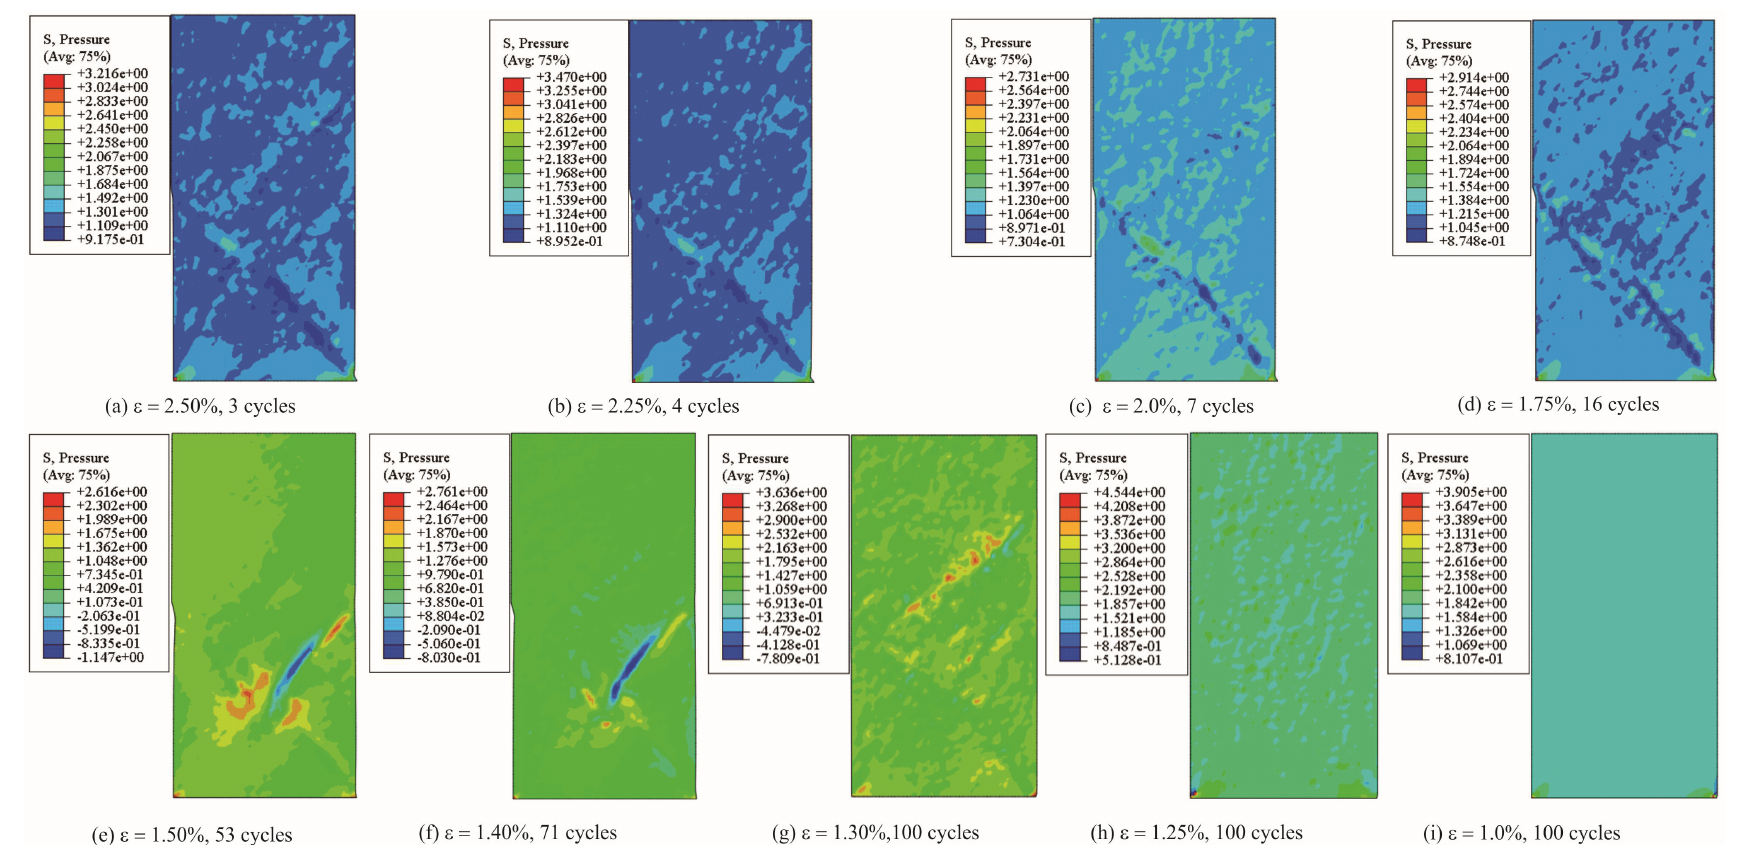
Figure 8. Hydrostatic stress distribution (described by “pressure” in ABAQUS) at fatigue limit or 100 cycles. ( a ) ε = 2.50%, 3 cycles; ( b ) ε = 2.25%, 4 cycles; ( c ) ε = 2.0%, 7 cycles; ( d ) ε = 1.75%, 16 cycles; ( e ) ε = 1.50%, 53 cycles; ( f ) ε = 1.40%, 71 cycles; ( g ) ε = 1.30%, 100 cycles; ( h ) ε = 1.25%, 100 cycles; ( i ) ε = 1.0%, 100 cycles. In which, the unit of pressure is actually denoted as σ hydrostatic / σ 0 in which σ 0 is 225MPa (according to the deduction process in reference [19]).